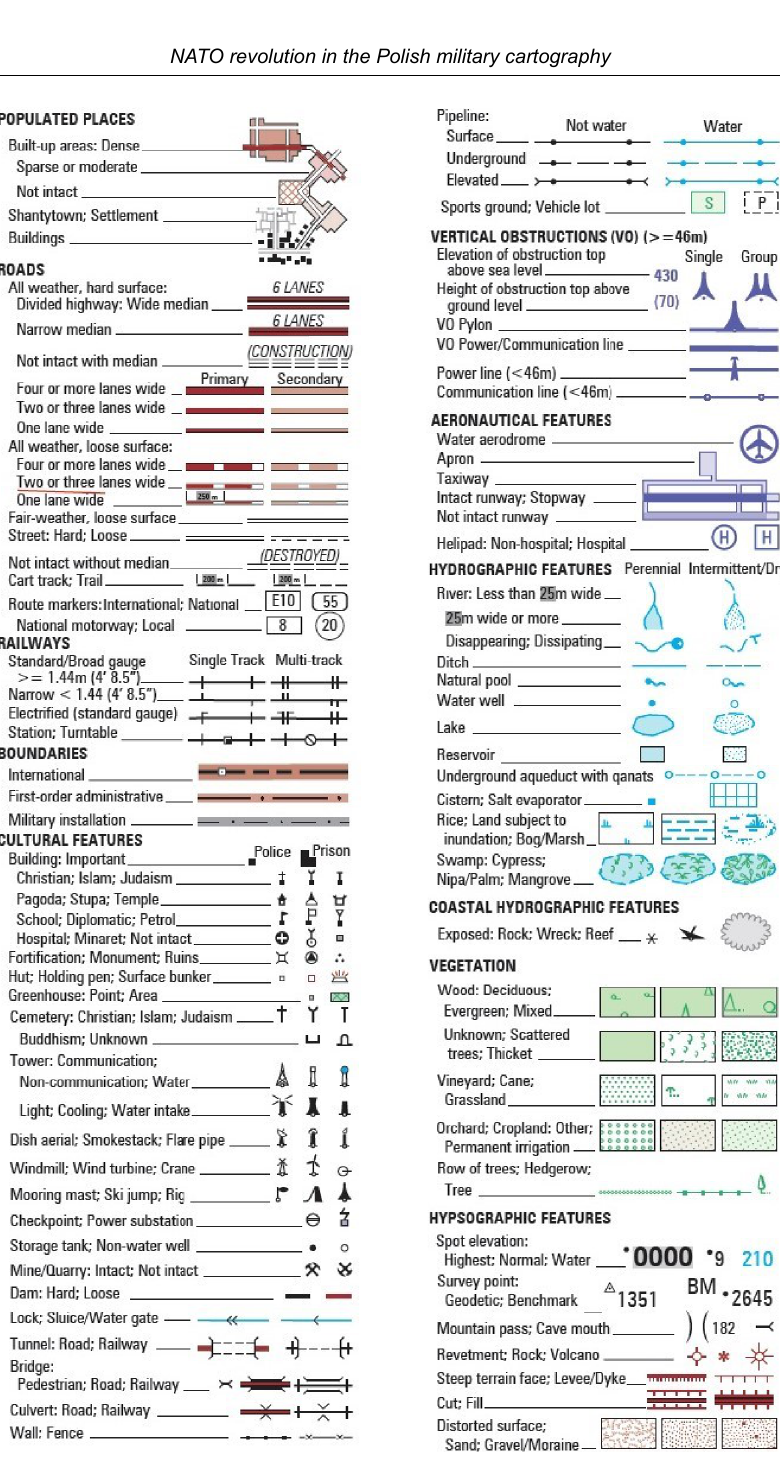
Fig. 4. Legend symbols